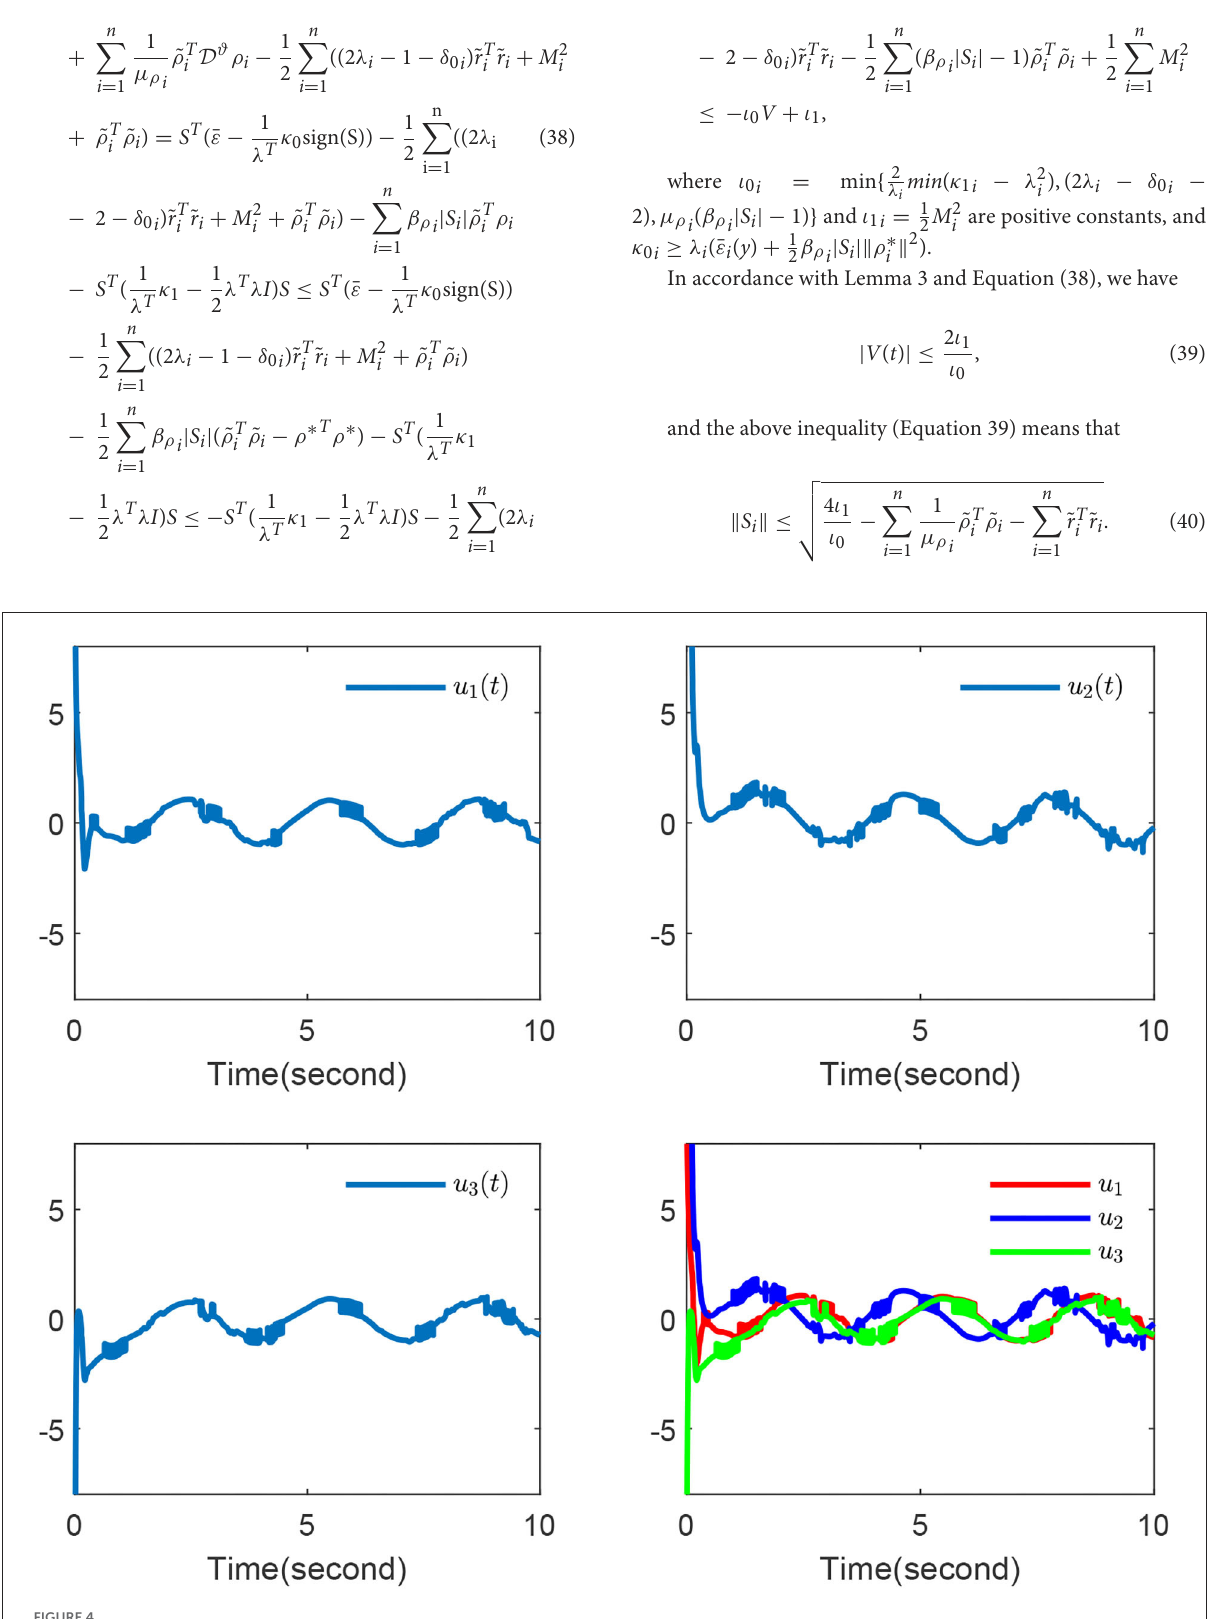
FIGURE4 Control